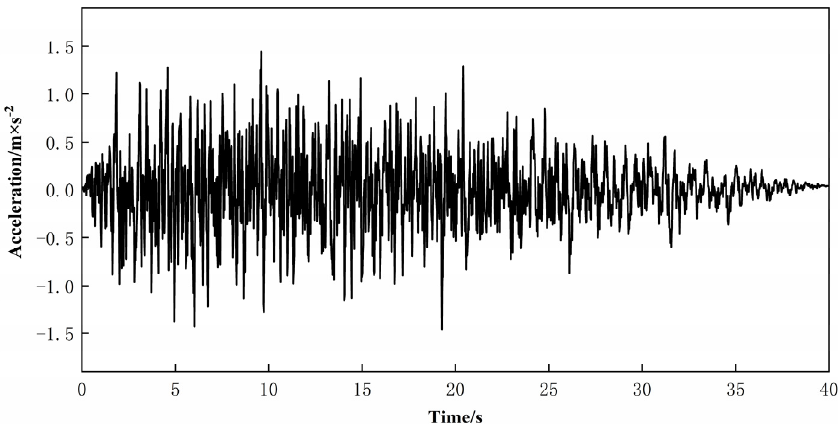
Figure 9. Earthquake acceleration time